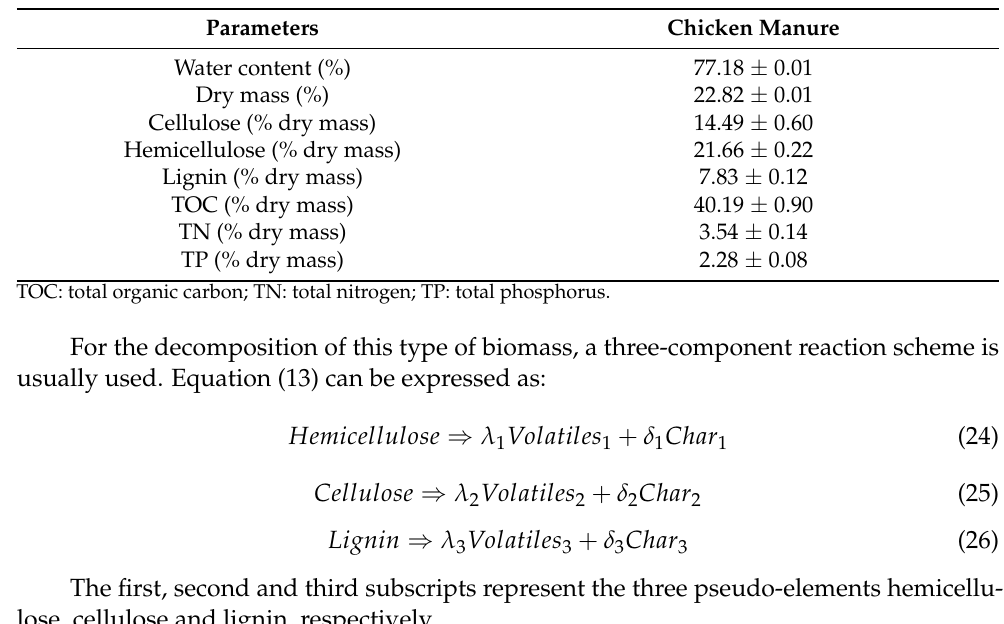
Table 6. Composition of chicken manure